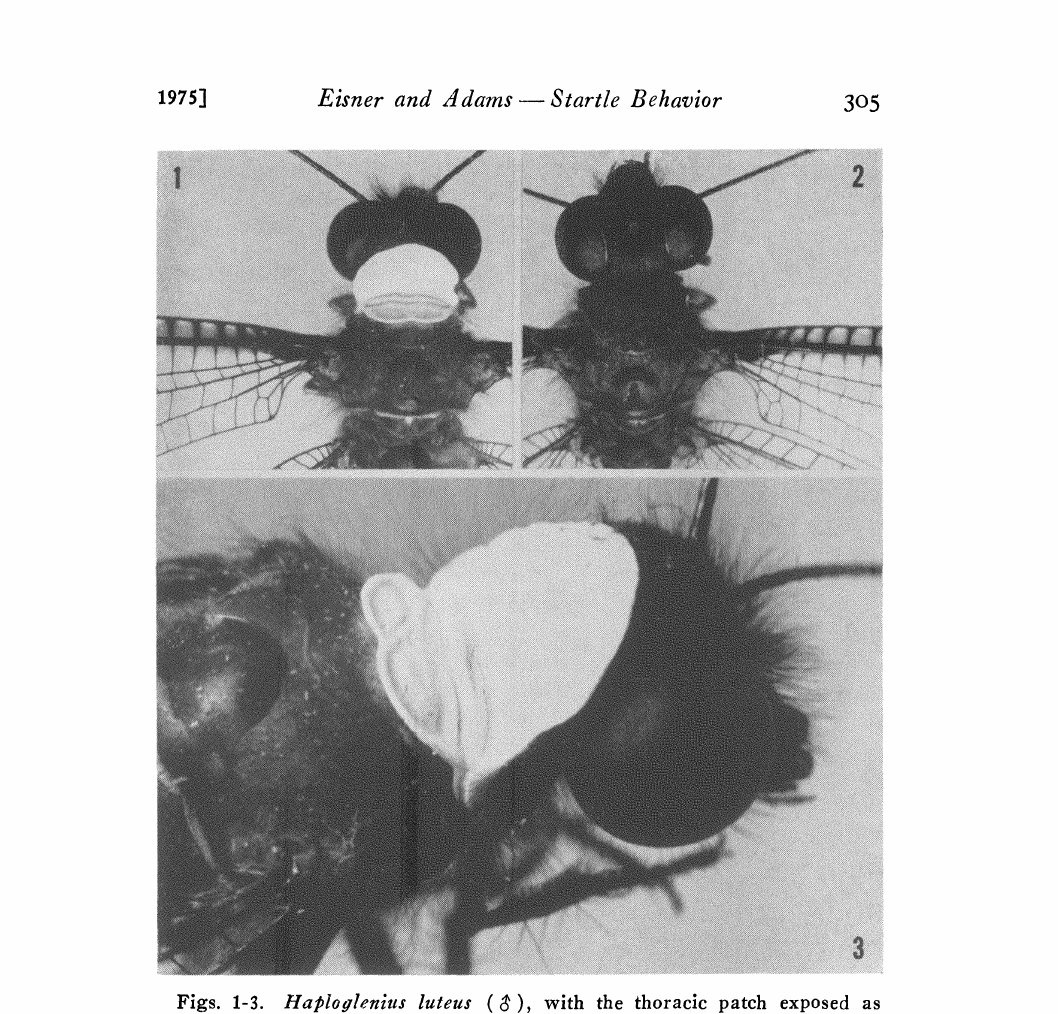
Figs. 1-3. Haploglenius luteus (8), with the thoracic patch exposed as in the startle display (fi.g. 1, 3), and concealed beneath the pronotal flap as it ordinarily is in the undisturbed animal (fig.